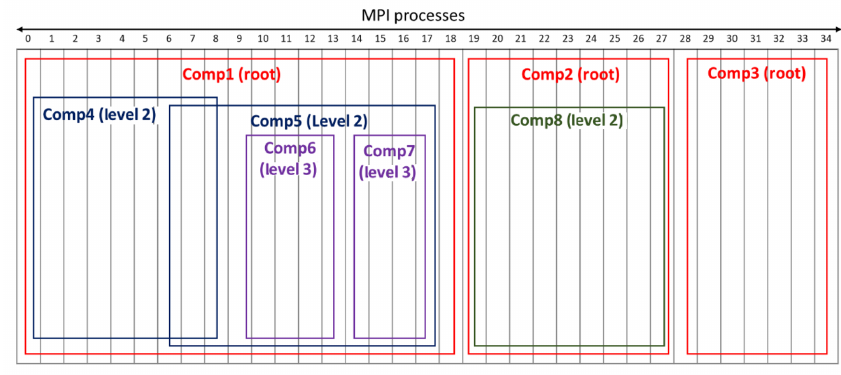
Figure 5. Sample process layout of component models